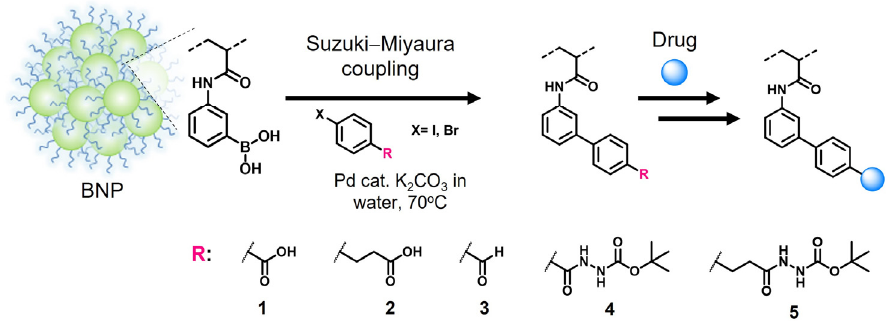
Figure 1. Functionalization of phenylboronic acid-containing framboidal nanoparticles via aqueous Suzuki–Miyaura coupling reaction with aryl halides containing different functional groups: ( 1 and 2 ) carboxylic acids, ( 3 ) aldehyde, ( 4 and 5 ) Boc-protected hydrazides.